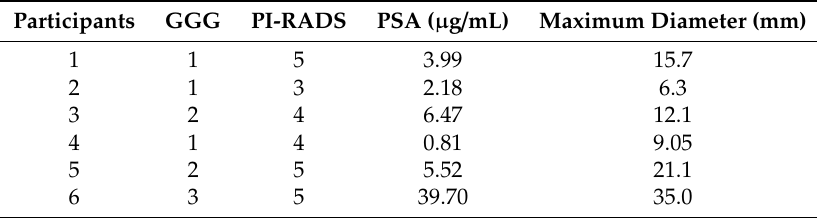
Table 4. Detailed clinical information for the six participants with histopathologically proven tumor.